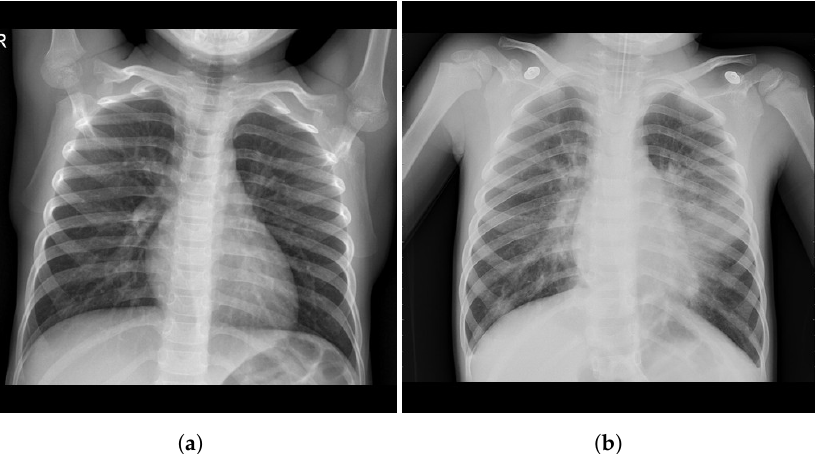
Figure 9. Examples images from CXRIP dataset. ( a ) Normal and ( b ) bacterial pneumonia